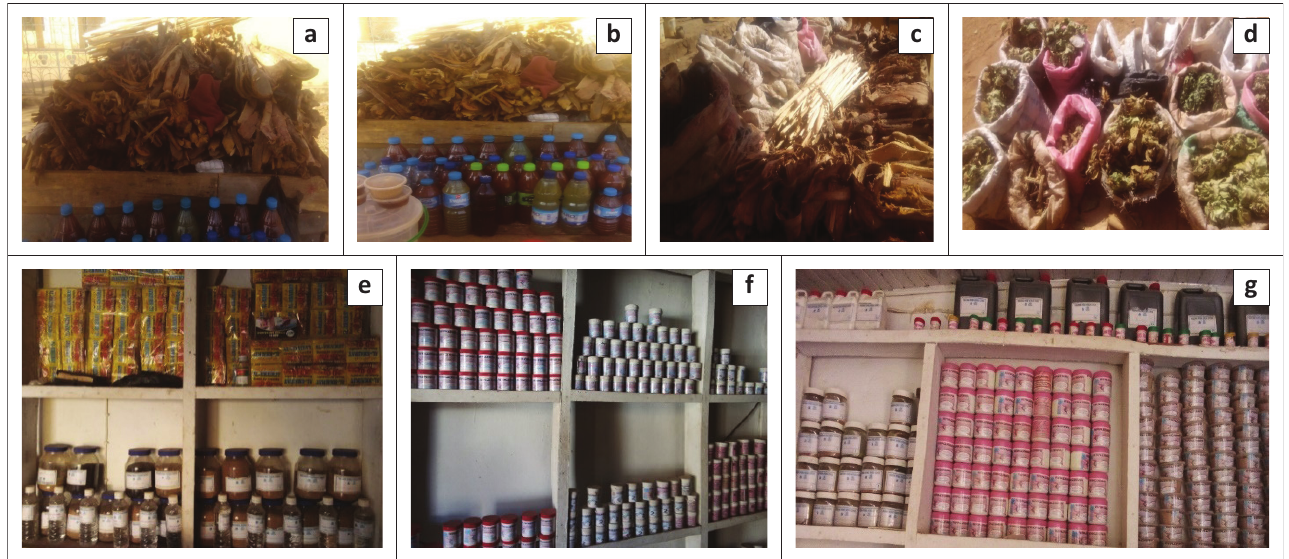
FIGURE 6: Refined herbal drugs (a–g) marketed by traditional healers in the study